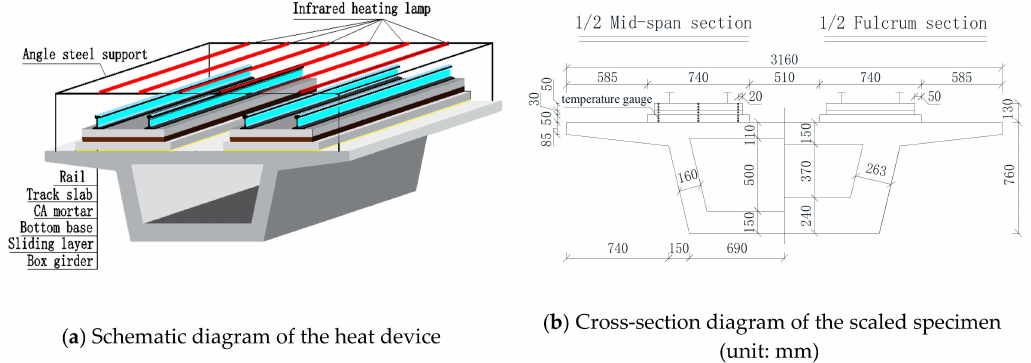
Figure 2. The extreme high temperature (EHT) test device